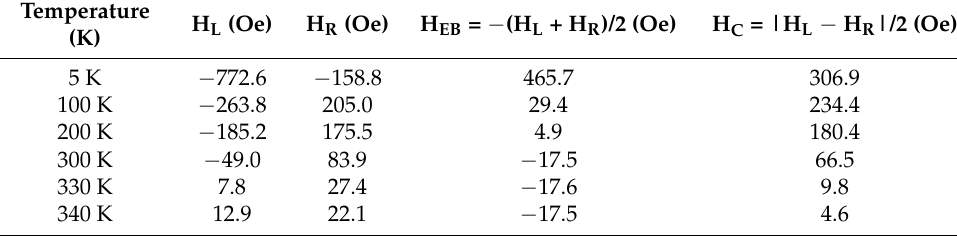
Figure 6. The M-H curves of the Ni-Co-Mn-In alloy film (#3) at different temperatures ( a , b ). The schematic diagram for the EB effect ( c , d ). Table 2. The H L , H R , H EB , and H C for the Ni-Co-Mn-In alloy film (#3) at different